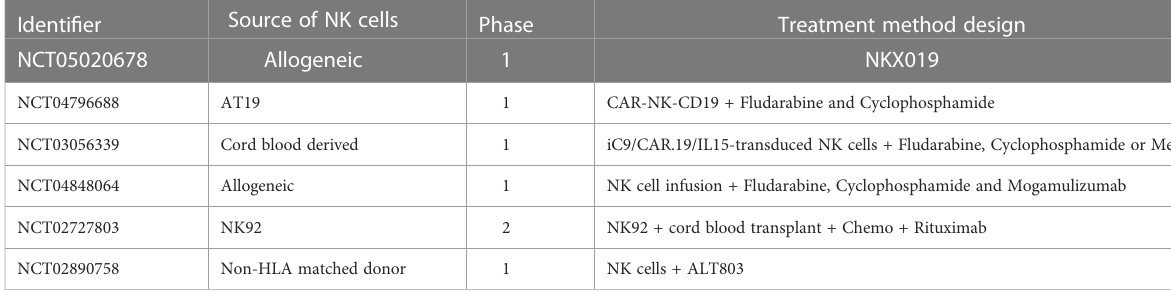
TABLE 2 Current NK-cell immunotherapy clinical trials for